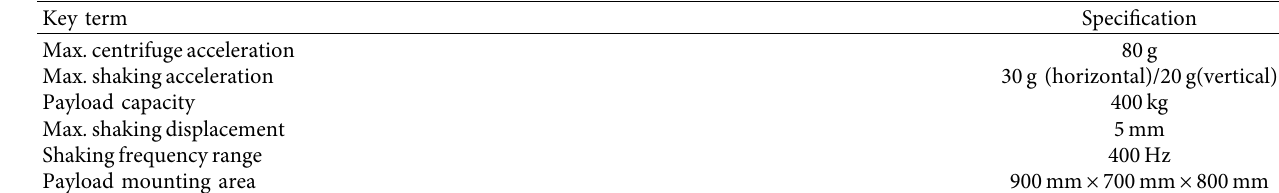
Table 1: Technical specifications of the centrifuge.